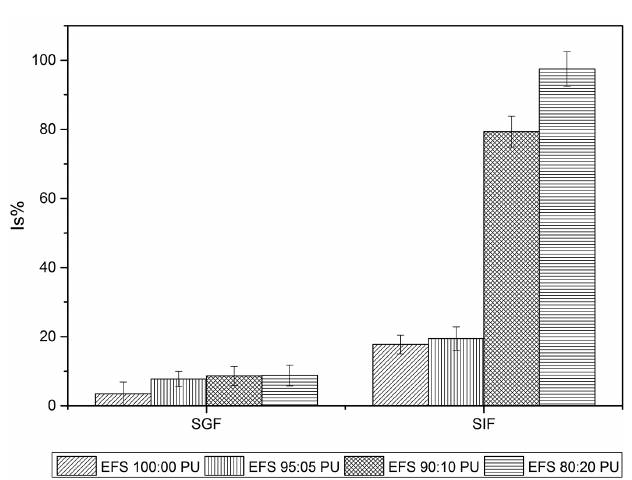
FIGURE 2 - Swelling index of films after 180 min immersion in SGF (pH 1.2) and SIF (pH 6.8)